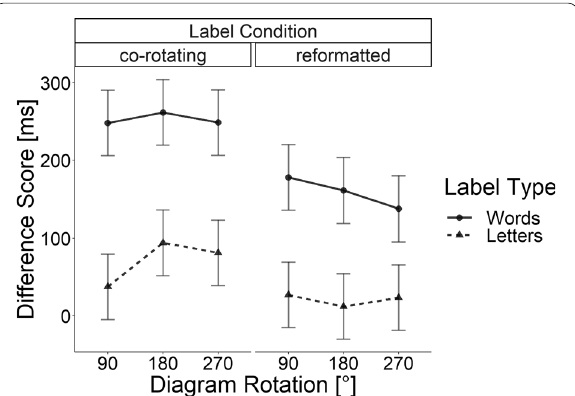
Fig. 5 Results of Experiment 1. Mean differences of the response onset relative to the baseline without rotation. Error bars are based on Fisher’s Least Significant Difference (LSD; Fisher,